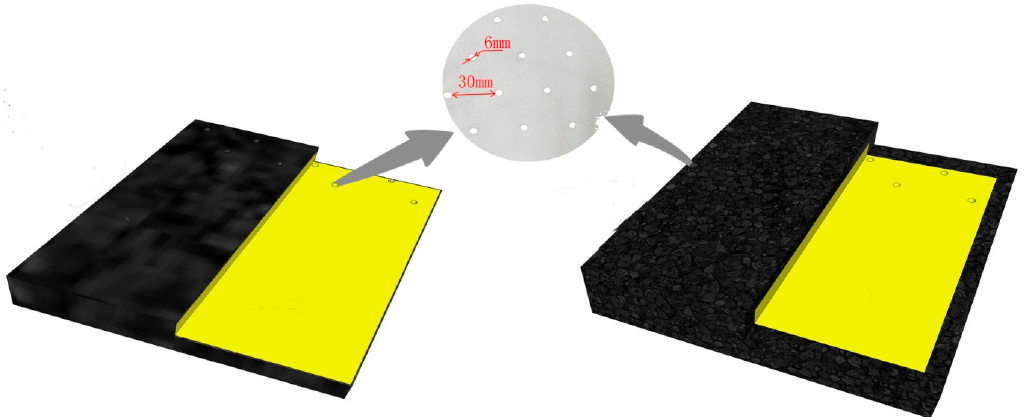
Figure 11. Residues distribution on the sample surface during the combustion.